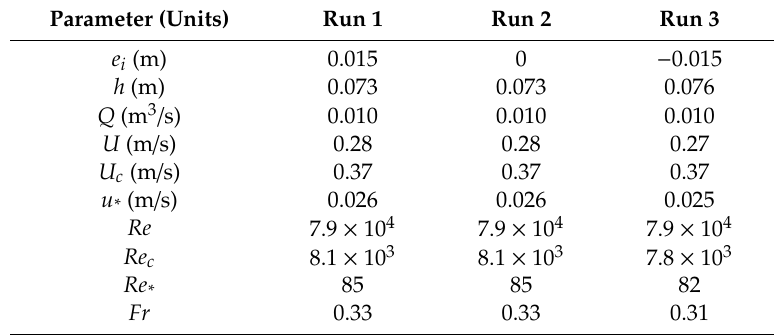
Figure 1. Schematic representation of the geometrical conditions of the experimental runs, where e i ( i = 1, 2, 3) is the gap between the lower edge of the cylinder and the bed surface. Table 1. Geometric and hydraulic parameters of the experimental